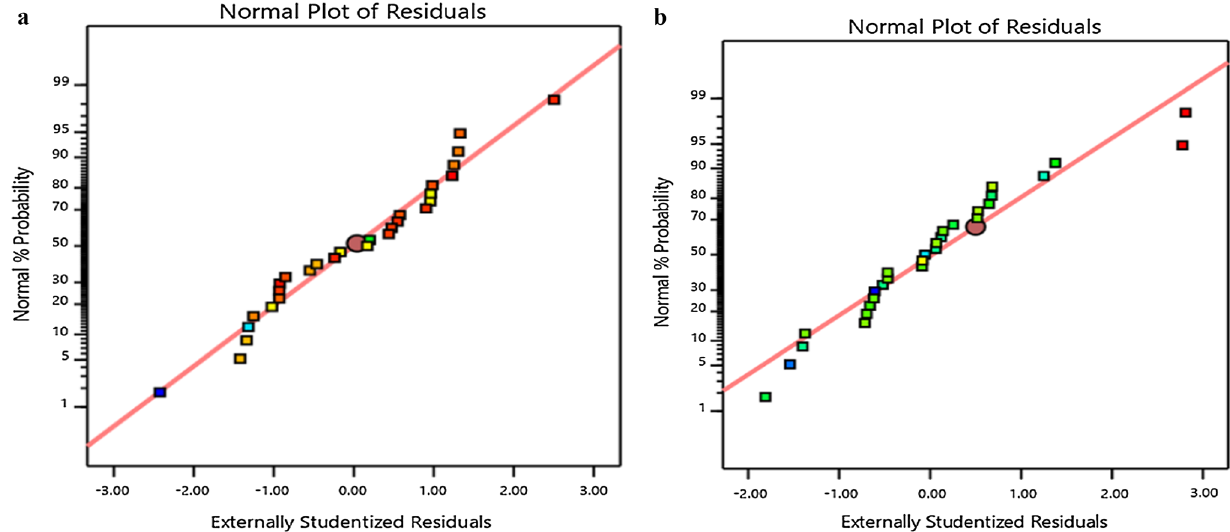
Fig. 2 Normal probability plots a Al-EC, b Fe-EC